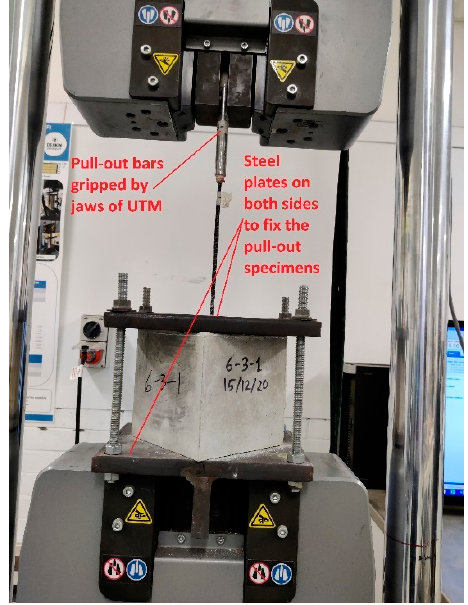
Figure 8. Placing of the pull-out specimen inside the UTM. The applied load was recorded by the data acquisition system and connected to the com- puter. During the loading, the slip of the basalt FRP bar corresponding to the applied load was measured continuously and recorded in the Bluehill software module of the Instron universal testing machine. The tests were run until failure for each individual specimen.